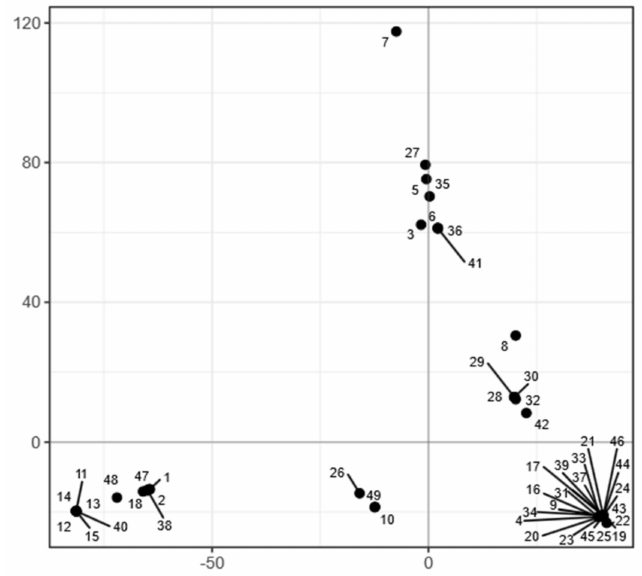
Figure 7. Clustering of A. melanogenum genomes. Principal component analysis of SNP data estimated by comparing the genomes to the reference A. melanogenum genome (EXF-3378). The genomes are represented by circles. The axes explain 33.11% (horizontal) and 19.85% (vertical) of